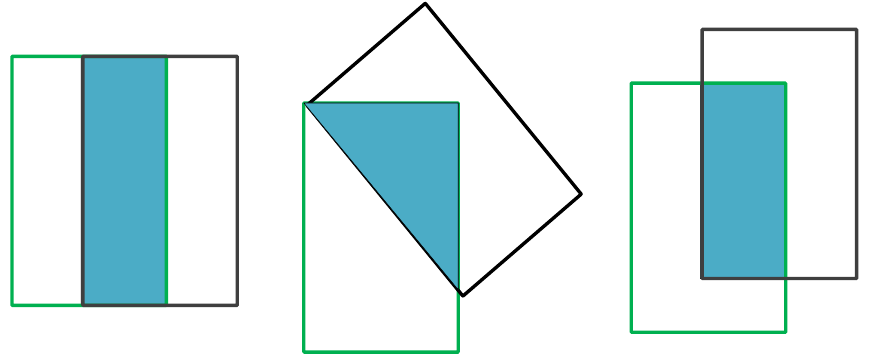
Figure 2. Three common ways of overlapping between the predicted box and ground truth box.